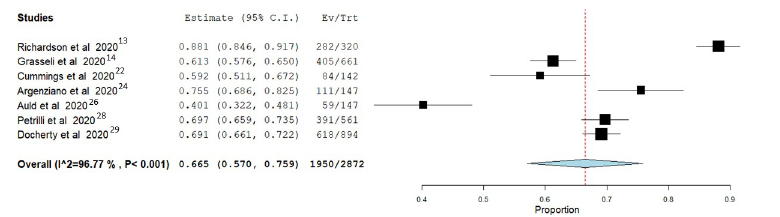
Fig 5. Meta-analysis for the studies that enrolled more than 100 patients.